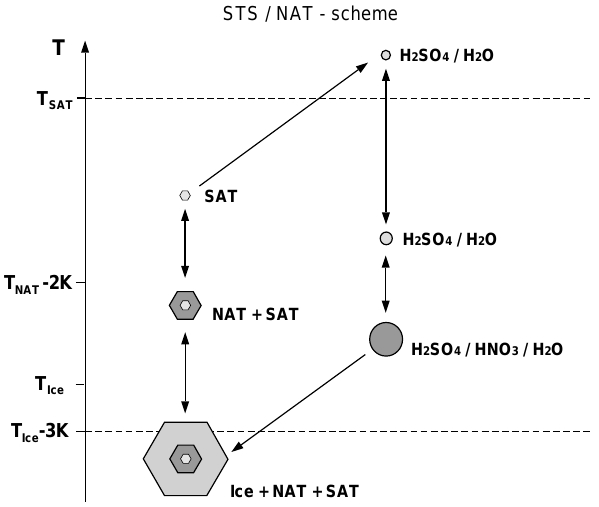
Fig. 1. Schematic overview of the particle types and the phase tran- sition pathways considered in the standard version of the model (STS/NAT-scheme, see Sect. 2.3.1 for